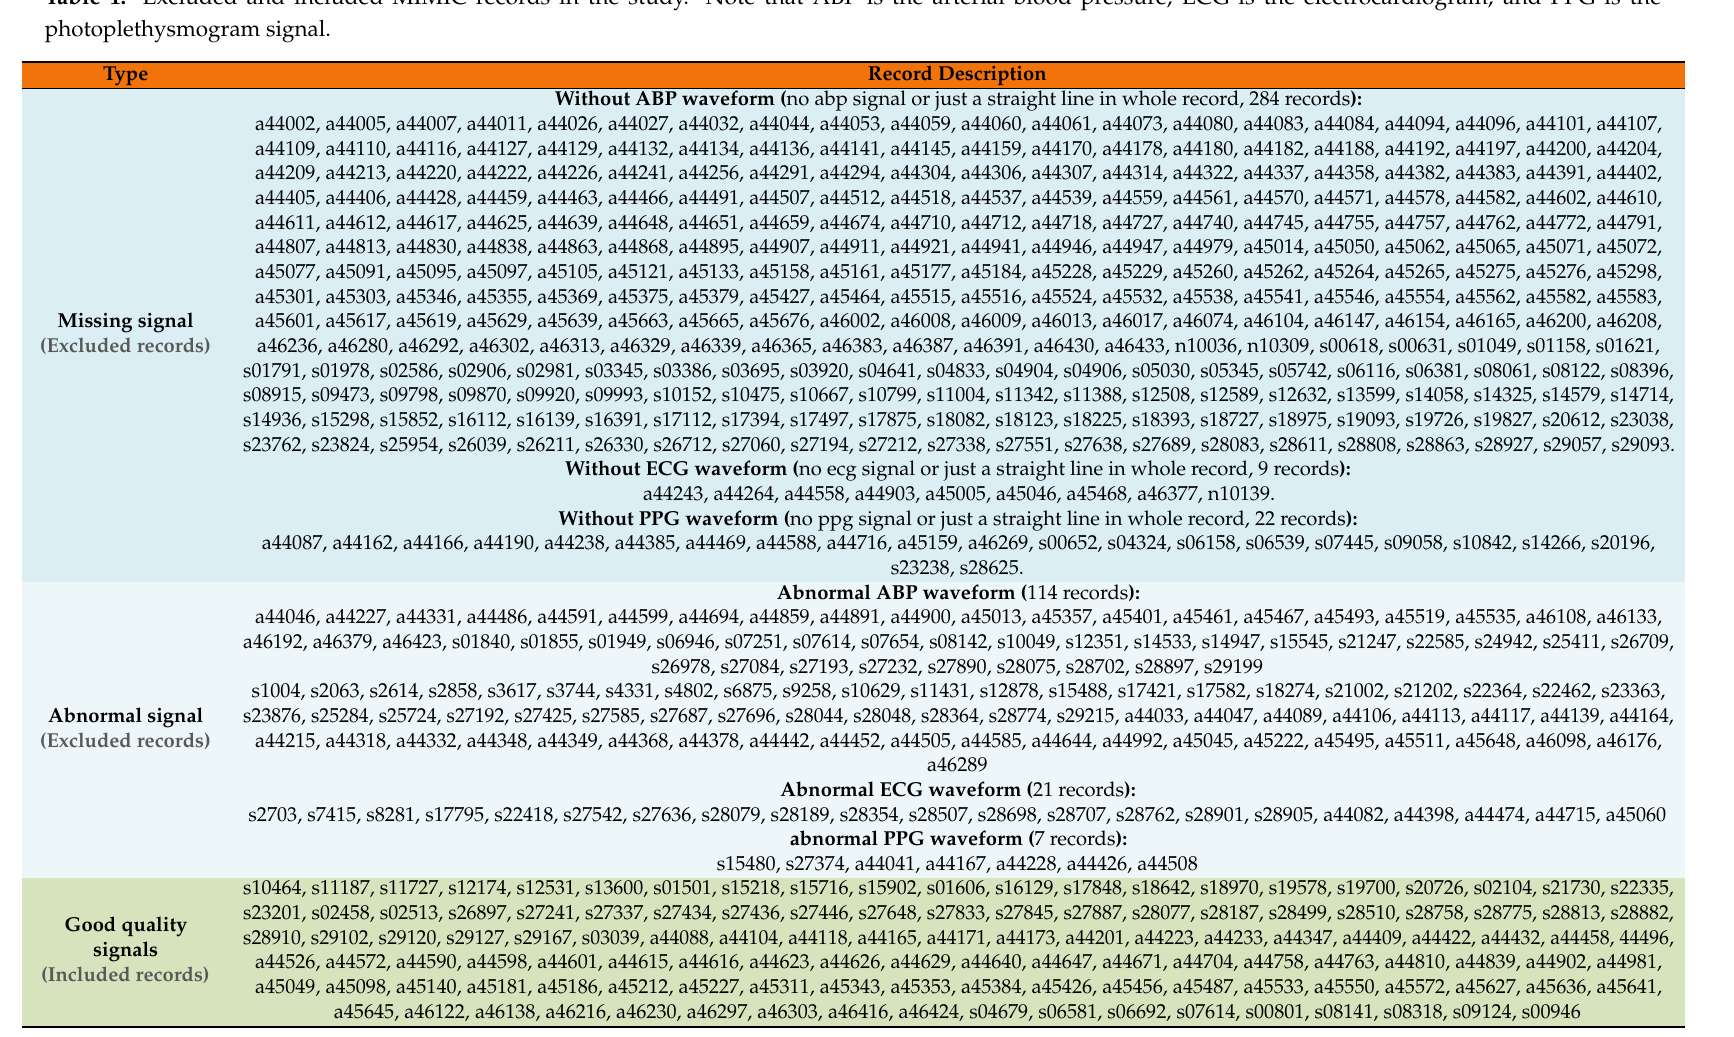
Table 1. Excluded and included MIMIC records in the study. Note that ABP is the arterial blood pressure, ECG is the electrocardiogram, and PPG is the photoplethysmogram